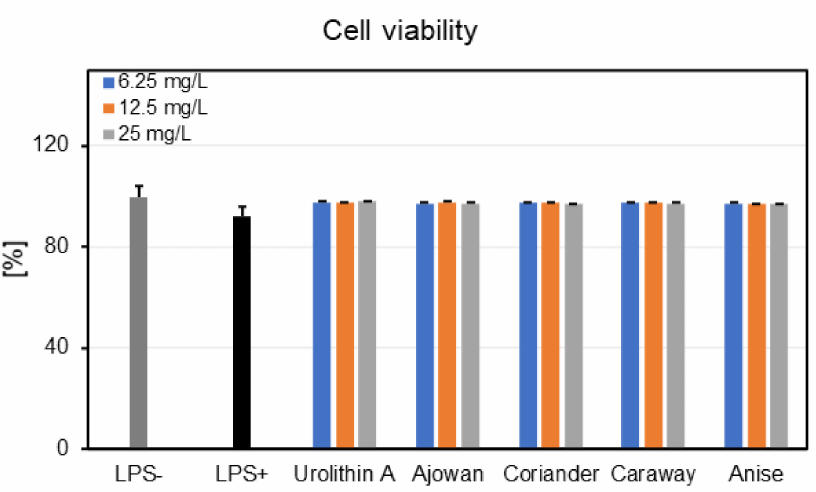
Figure 1. Neutrophils viability (%) following 24 h-treatment with essential oils of ajowan, corian- der, caraway, and anise (6.25–25 mg/L), as well as urolithin A (12.5, 25 and 50 µ M). Results are expressed as mean ± SEM of three separate experiments performed with cells isolated from four independent